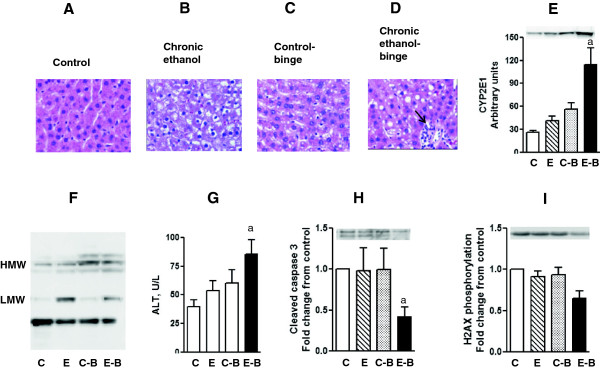
Parameters of liver injury and histology after chronic and chronic ethanol- three binge. Rats were fed ethanol in liquid diet chronically for 4 weeks and then given 3 binge (5 gm/kg) at 12 hr intervals. Four hours after the last dose, the levels of serum ALT, and hepatic cleaved caspase-3 were determined as described under Materials and Methods. Sections of liver samples were stained with hematoxylin and eosin. Control represents pair –fed animals and were given water for binge control. Values are mean ± SE (n = 3 rats). Western blot represents a typical experiment. A-D: Hemotoxylin and eosin staining (x 200X); E: CYP2E1 protein expression. F: 4-HNE immunoblot G: Serum ALT; H: hepatic cleaved caspase 3; I: H2AX phosphorylation a: significant from control group (p < 0.05); C: Control (pair fed); E: Chronic ethanol; C-B: Control- ethanol binge; E-B: Chronic-ethanol binge. LMW: low molecular weight; HMW: high molecular weight; Small solid arrow represents leukocyte infiltration.